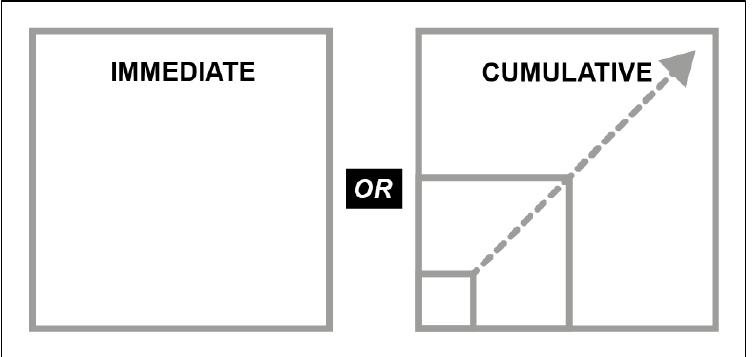
Figure 4. Mode of Impact—Emergence. The third mode of impact is emergence. Emergence examines whether the impacts of a negative externality are felt immediately or gradually, over time. An example of a negative externality that emerges immediately is decreased agricultural/prairie land, whereas an example of a negative externality that emerges incrementally is increased surface urban heat island intensity.